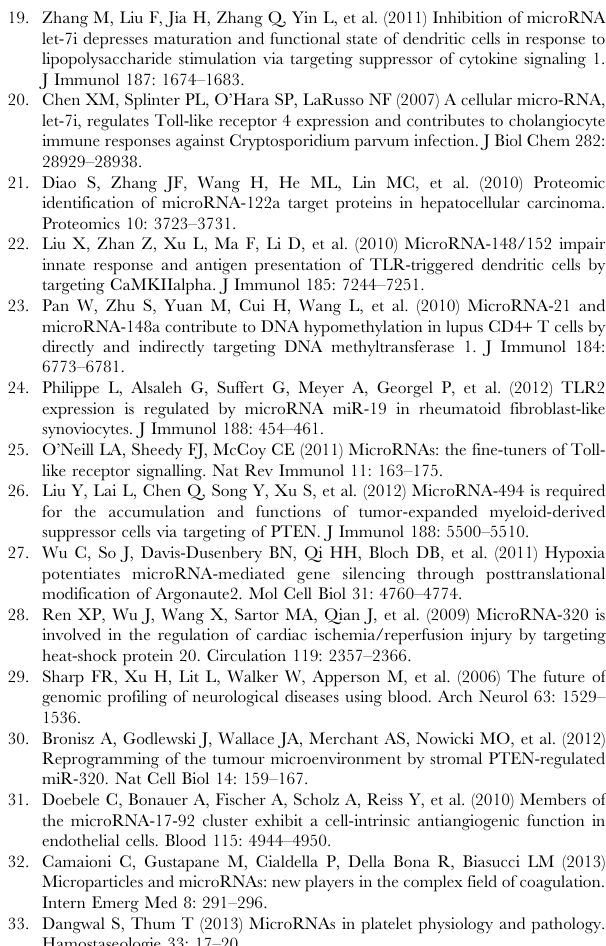
Figure S1 Relative microRNA expression in patients with acute ischemic stroke compared to vascular risk factor controls. Expression determined by qRT-PCR relative to U75, with lowest expressing miRNA assigned a value of 1. Table S1 microRNA differentially expressed between acute ischemic stroke and vascular risk factor controls.